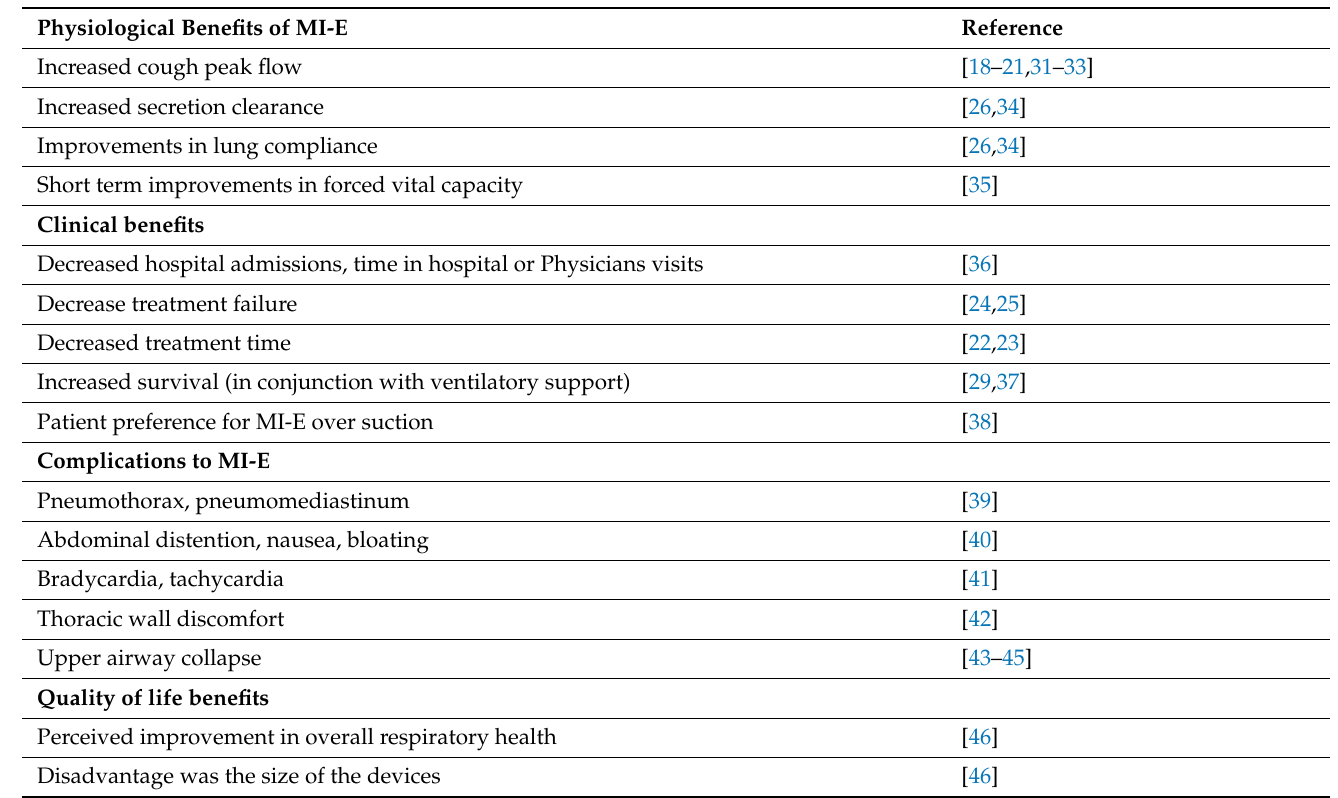
Table 1. Literature pertaining of physiological, clinical, quality of life benefits and literature compli- cations of